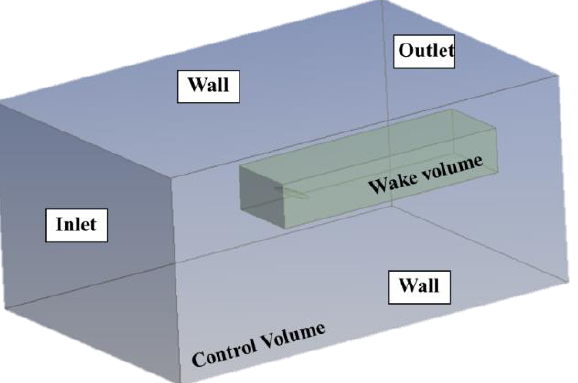
Figure 5. Definition of boundary conditions for numerical simulations. ( U ∞ = 10 m/s, α = β = 0 ◦ )